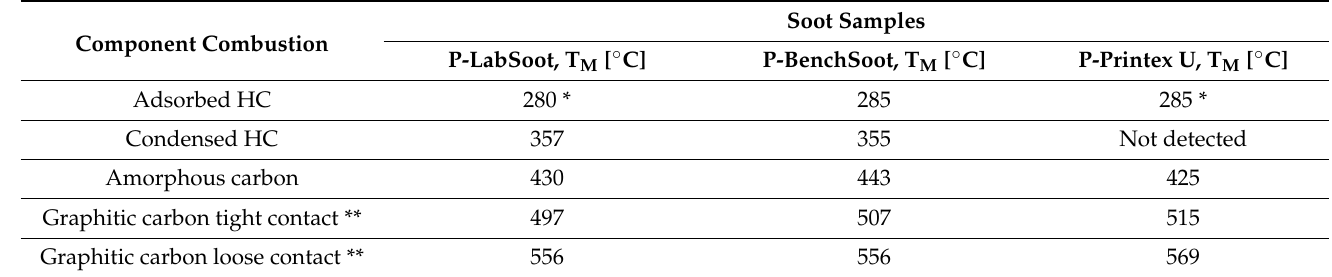
Table 4. Maximum combustion rate temperatures of the different fractions of soot deposited on ceramic papers without binder (from deconvoluted curves of Figure